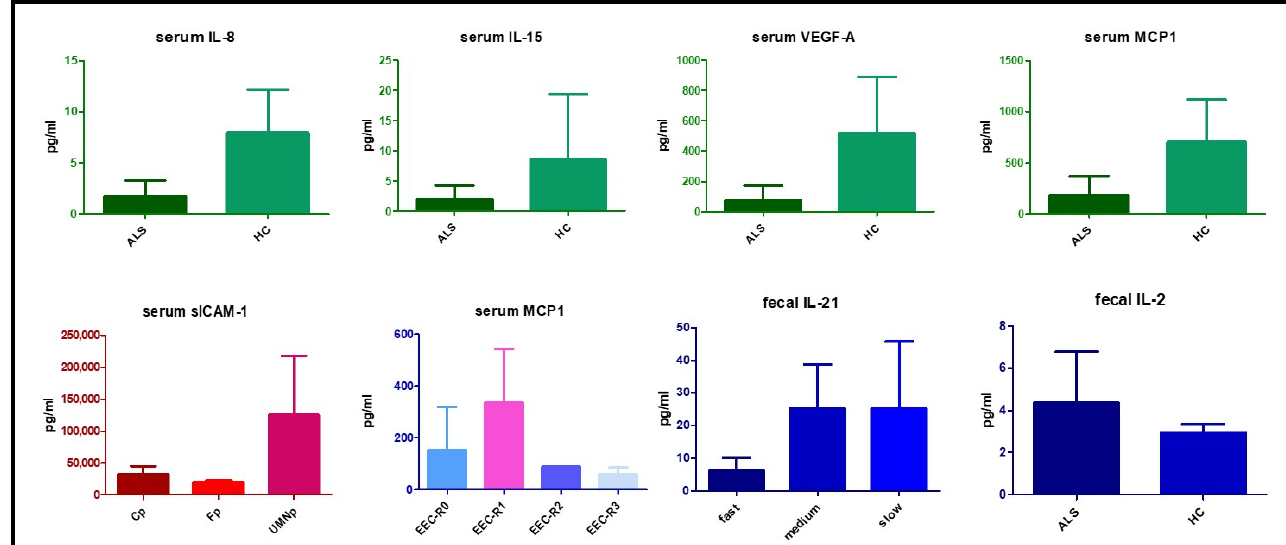
Figure 1. Serum and fecal cytokines with a significant different distribution among patient subgroups and controls. ALS = amyotrophic lateral sclerosis. HC = healthy controls. EEC = EL Escorial Criteria; EEC-R0 = definite; EEC-R1 = clinically probable; EEC-R2 = probable-laboratory-supported; EEC-R3 = possible. Bp = Bulbar phenotype; Cp = Classic phenotype; Fp = Flail arm/leg phenotype; UMNp = Upper Motor Neuron predominant phenotypes.